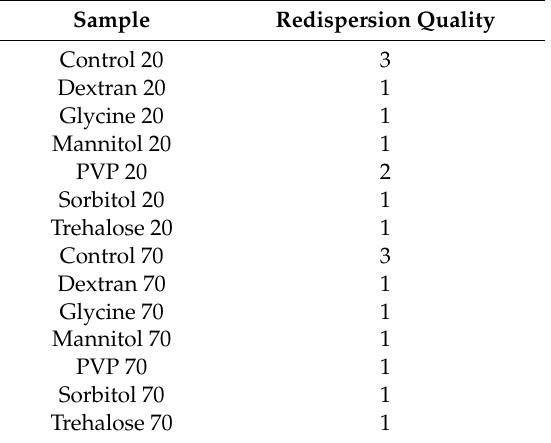
Table 4. Freeze–thaw study: Effect of cryoprotectant on the redispersibility of SLNs on reconstitution after lyophilization. Redispersion qualitative scale: 1—fully redispersed within 30 s of vortexing; 2—a few remaining undispersed visible agglomerates still present after 30 s of vortexing; 3—very little or no redispersion of solid after 30 s of vortexing.